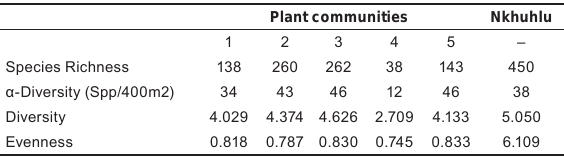
Richness, diversity and evenness for plant communities of the Nkhuhlu exclosure